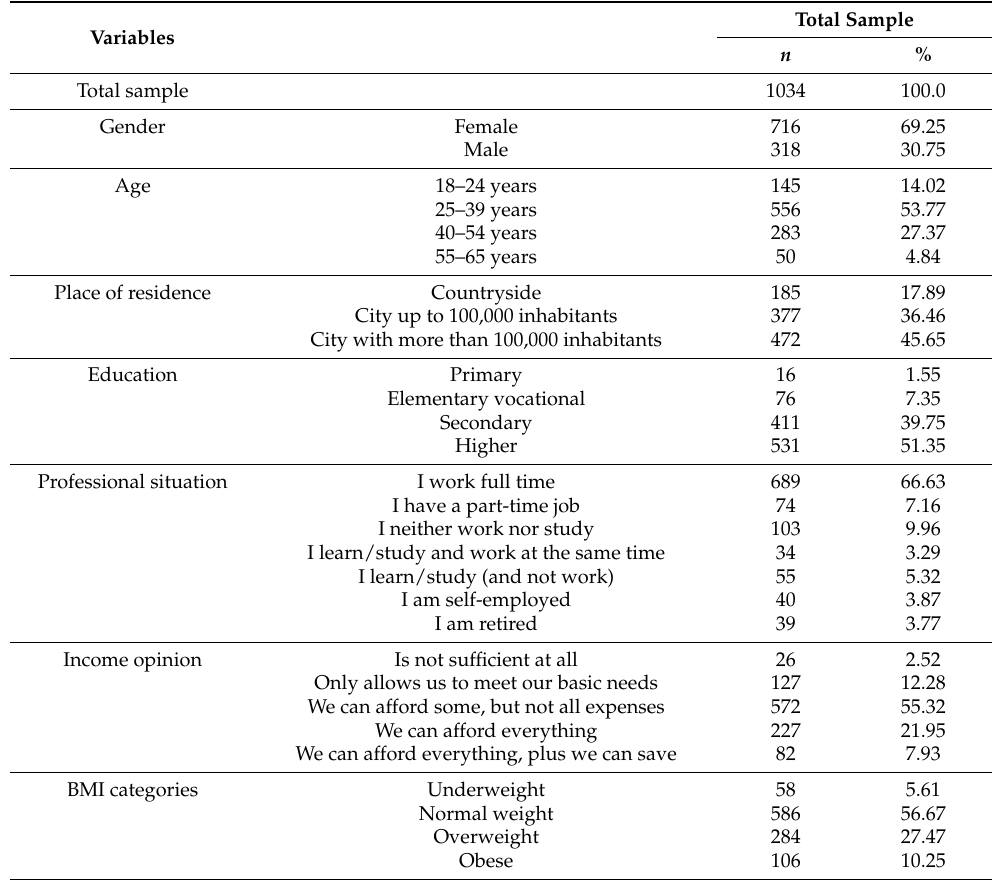
Table 1. Socio–demographic Characteristics of the study